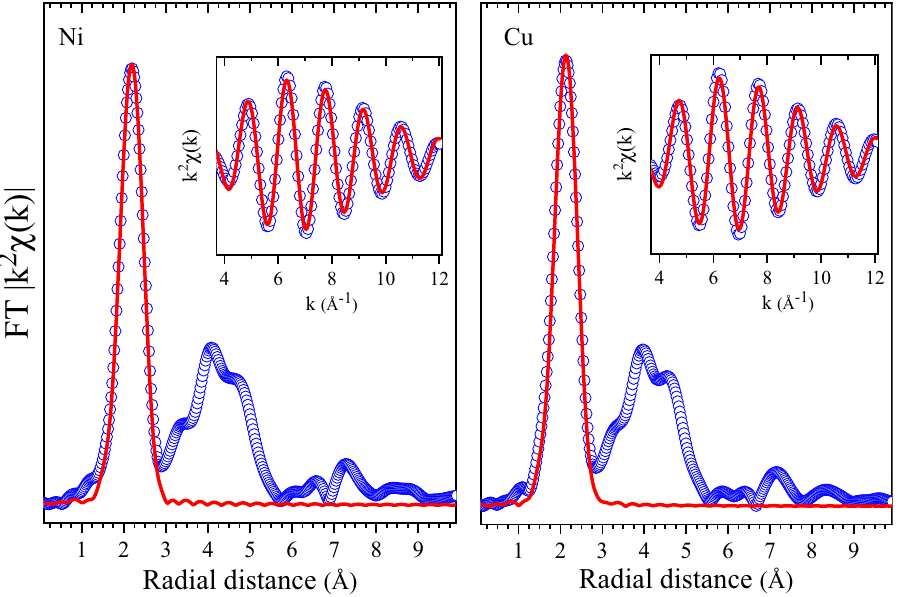
Figure 3. Fourier transform (FT) magnitudes of the Ni and Cu K-edge EXAFS (symbols) together with the results of the first shell modelling (solid lines). Insets shows the filtered EXAFS oscillations (weighted by k 2 ) corresponding to the first shell. In the insets, symbols are experimental data and solid lines are the model.